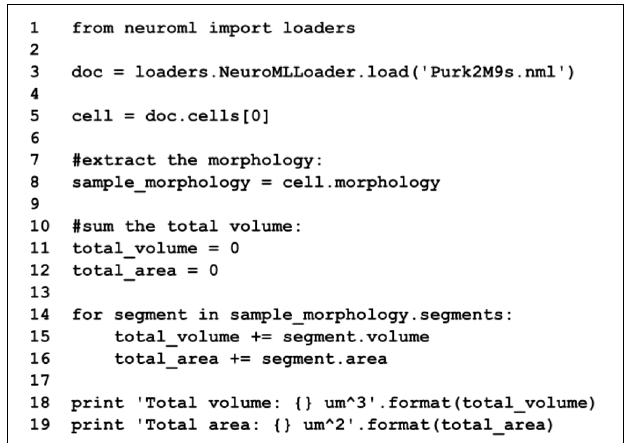
the NeuroML Schema.